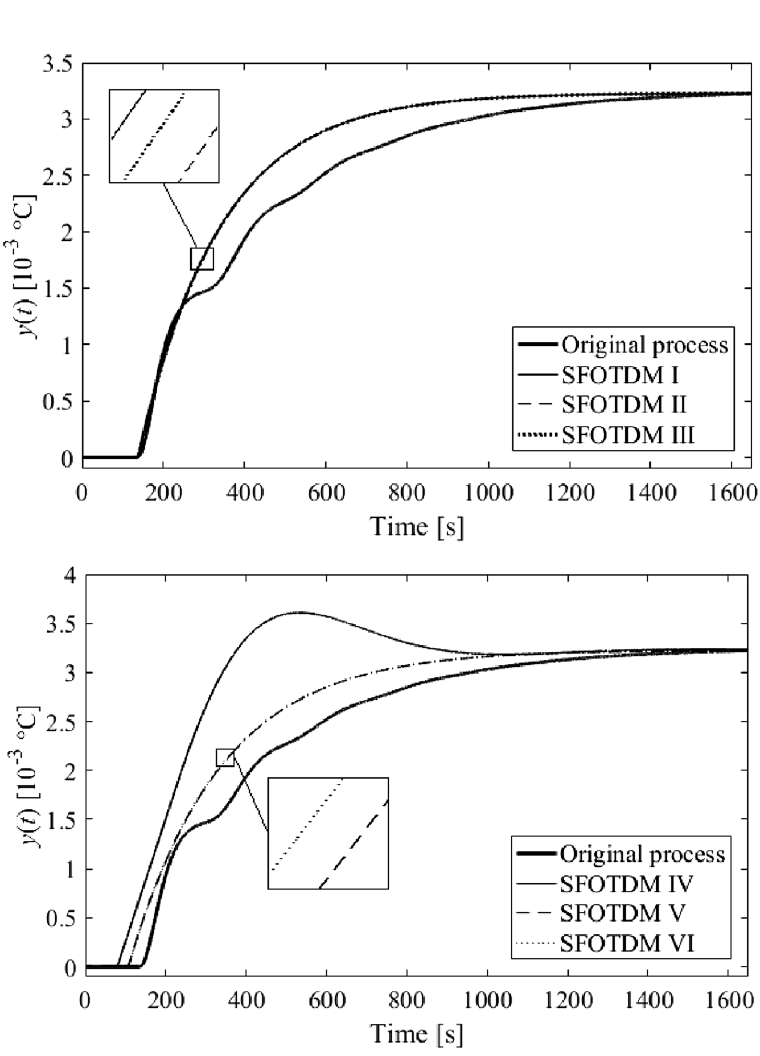
Figure 10. Comparison of SFOTDM unit step responses (vs. the original process